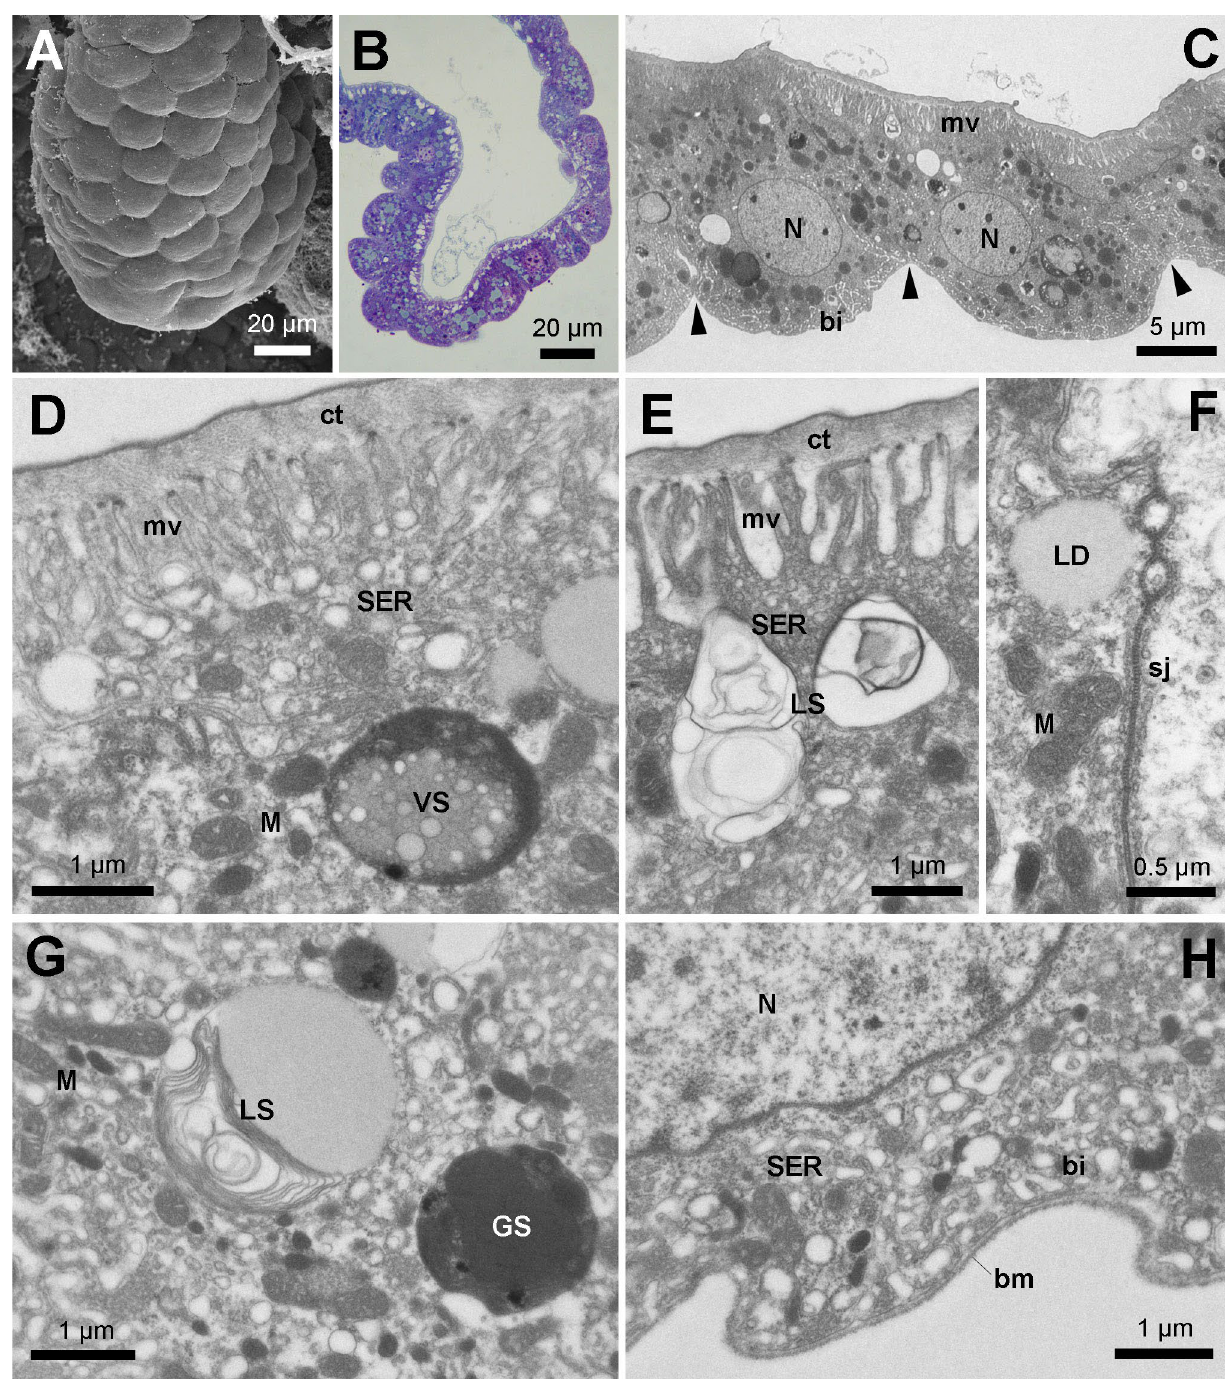
Fig 4 . Postpharyngeal gland. A . Scanning micrograph of globular external surface. B . Semithin section showing globular shape of gland epithelium. C-H: Electron migrographs. C . Survey of globular epithelium, arrowheads indicate where ventral cell junctions occur. D . Apical cytoplasm with vesicular secretion. E . Apical cytoplasm with lamellar secretion. F . Intercellular contact region with septate junctions. G . Cytoplasmic detail with lamellar and granular secretion. H . Basal cytoplasm showing numerous basal invaginations. bi: basal invaginations, bm: basement membrane, ct: cuticle, GS: granular secretion, LD: lipid droplet, LS: lamellar secretion, M: mitochondria, mv: microvilli, N: nucleus, pi: peripheral invaginations, SER: smooth endoplasmic reticulum, sj: septate junction, VS: vesicular